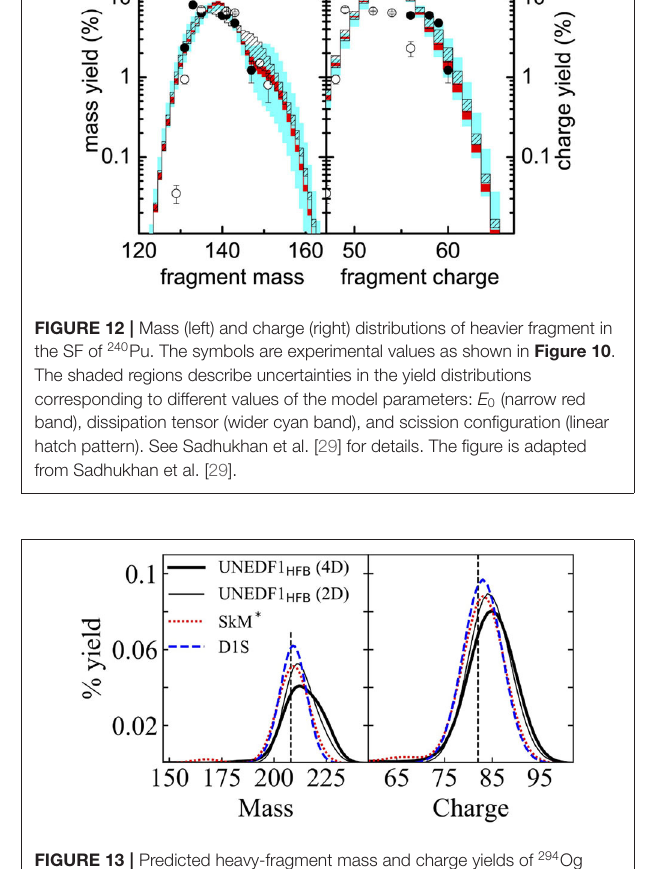
FIGURE 13 | Predicted heavy-fragment mass and charge yields of 294 Og obtained by employing UNEDF1 H FB functional in the 4D ( Q 20 , Q 22 , Q 30 , λ 2 ) and the 2D ( Q 20 , Q 30 ) spaces, and in the 2D ( Q 20 , Q 30 ) space for other functionals (SkM ∗ and D1S). The figure is adapted from Matheson et al. [ 66].